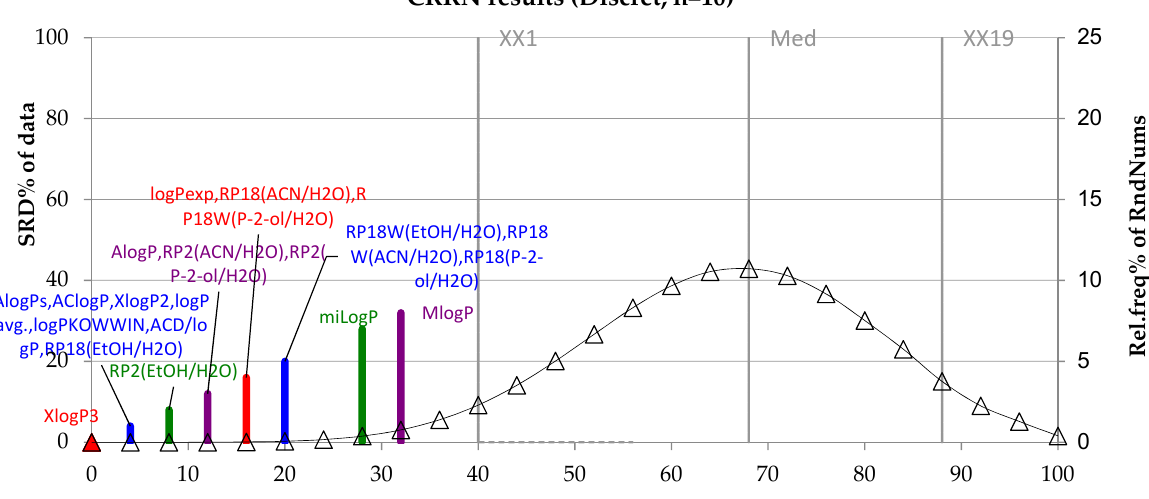
Figure 4. Plot of case projections on the plane of factors for analyzed compounds.